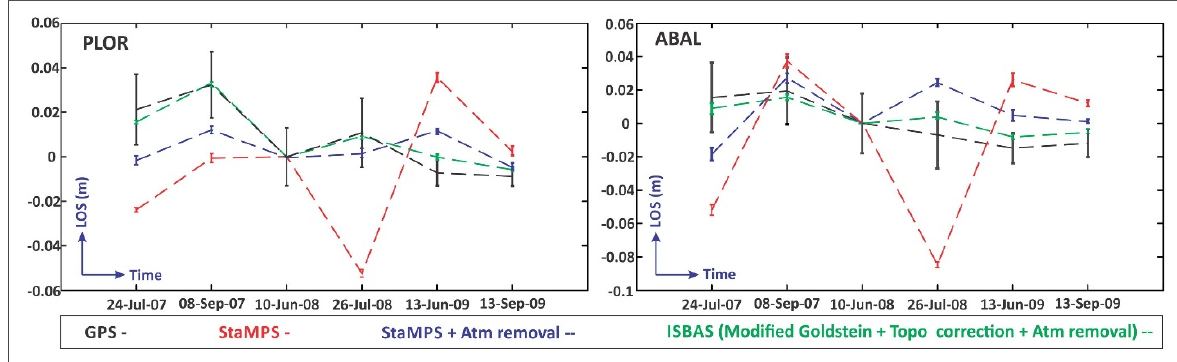
Figure 15. Comparison between GPS-derived LOS measurements and Envisat ascending observations for four GPS stations.